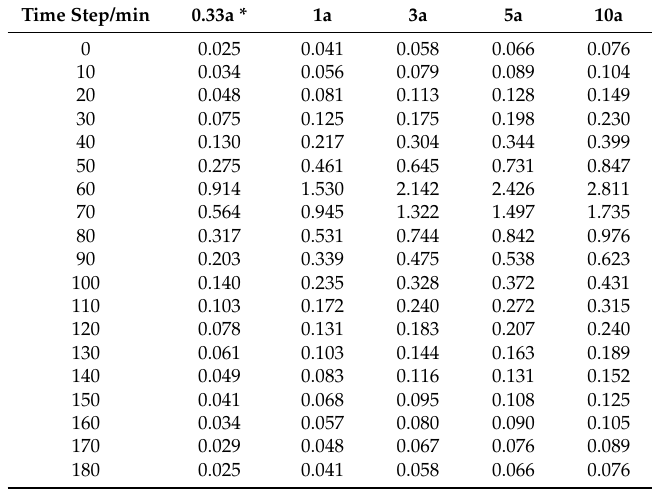
Table 2. Distribution of 3 h of rainfall under different rainfall repetition periods.